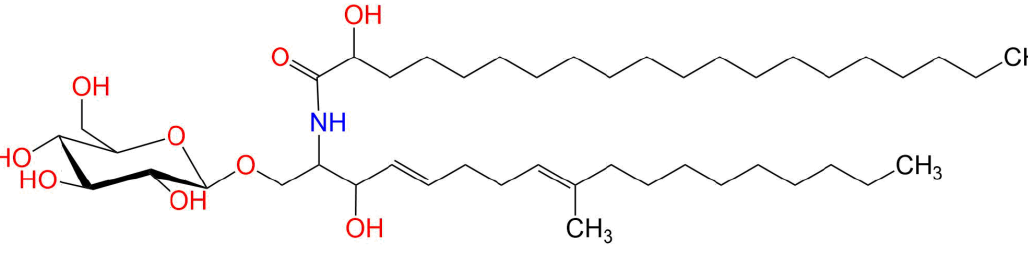
Figure 11. Structures of glucosylceramides ( 101 – 104 ) isolated from F. oxysporum .